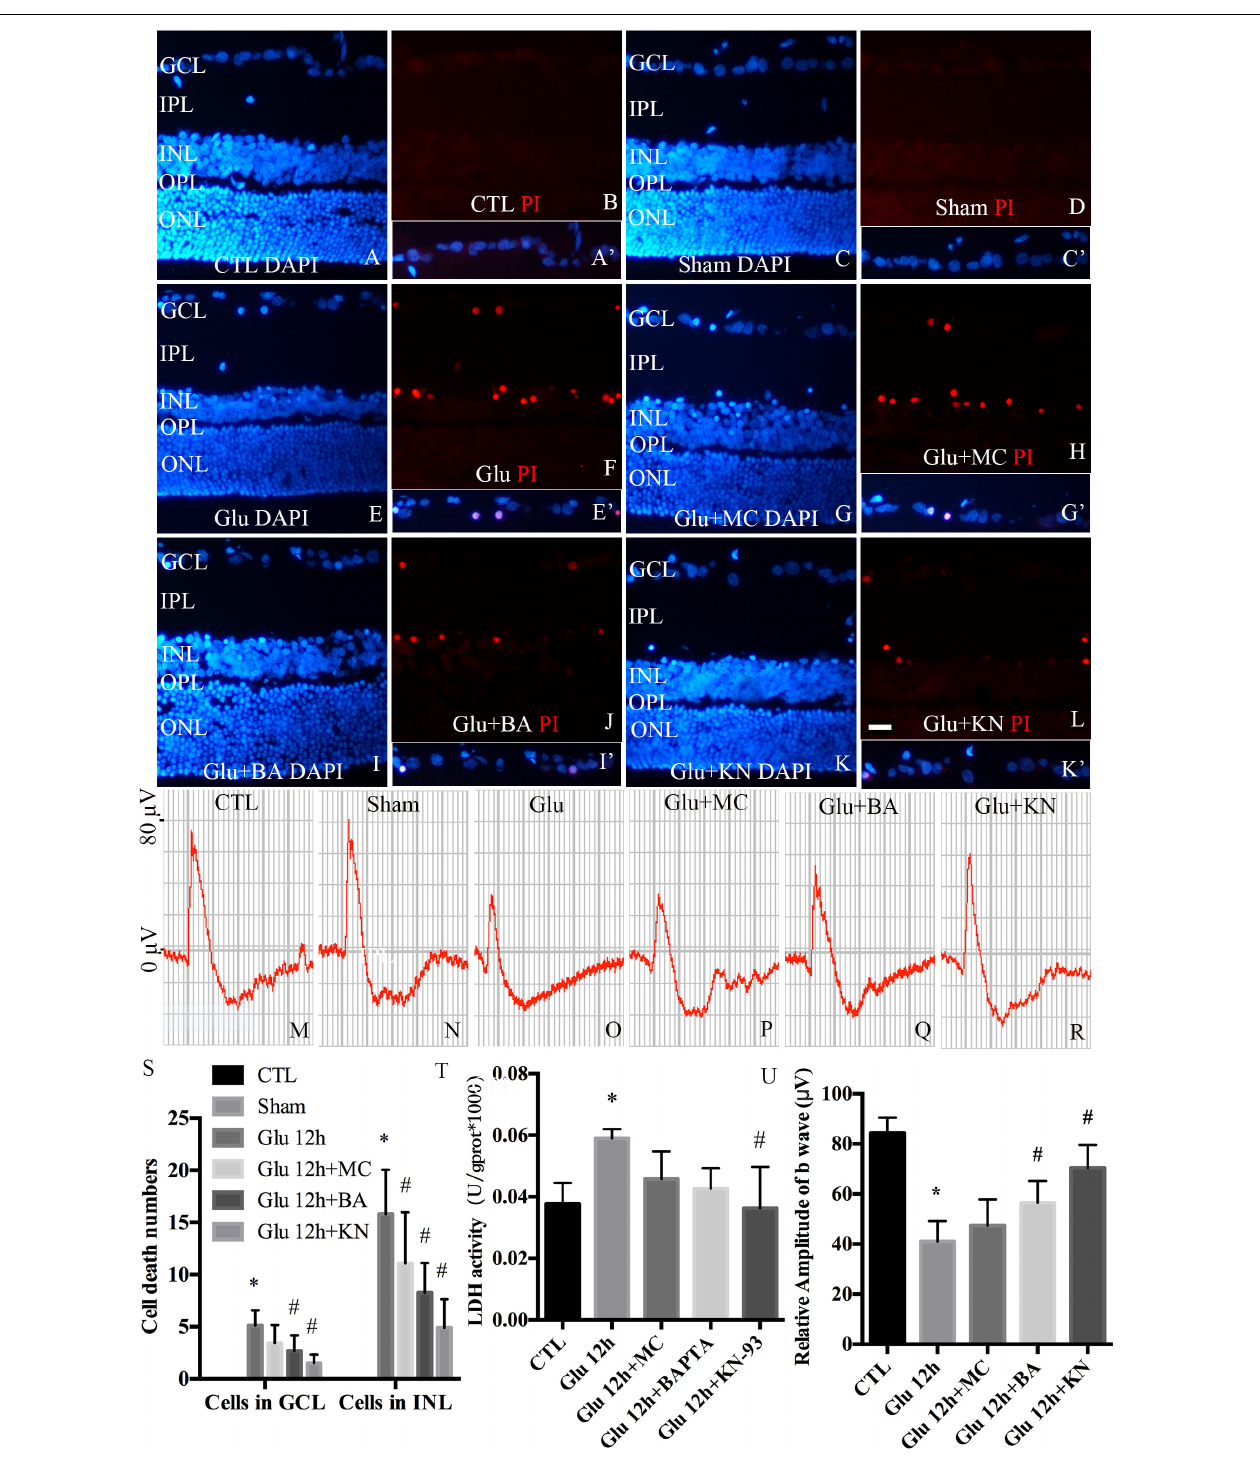
FIGURE 8 | Necrosis and visual function in retina in vivo. (A,C,E,G,I,K) Nuclei were stained with DAPI (blue). (B,D,F,H,J,L) Retinal necrotic neurons were stained with PI (red). Nuclei and PI stained cells in GCL as indicated are shown in the merged frame areas ( A (cid:48) ,C (cid:48) ,E (cid:48) ,G (cid:48) ,I (cid:48) ,K (cid:48) ) . (M,N,O,P,Q,R) Representative fERG results of groups treated with glutamate and pretreated with different drugs. (S) Statistical analysis of PI stained cells in GCL and INL in retina. (T) The percentage of necrosis cells were determined by LDH release assay. (U) Statistical analysis of the b wave amplitudes. ∗ p < 0.05 vs. CTL group, # p < 0.05 vs. Glu group. Each group was composed of four animals. Data were analyzed using one-way ANOVA. GCL, ganglion cell layer; IPL, inner plexiform layer; INL, inner nuclear layer; OPL, outer plexiform layer; ONL, outer nuclear layer. Scale bar = 20 µ m in all panels.